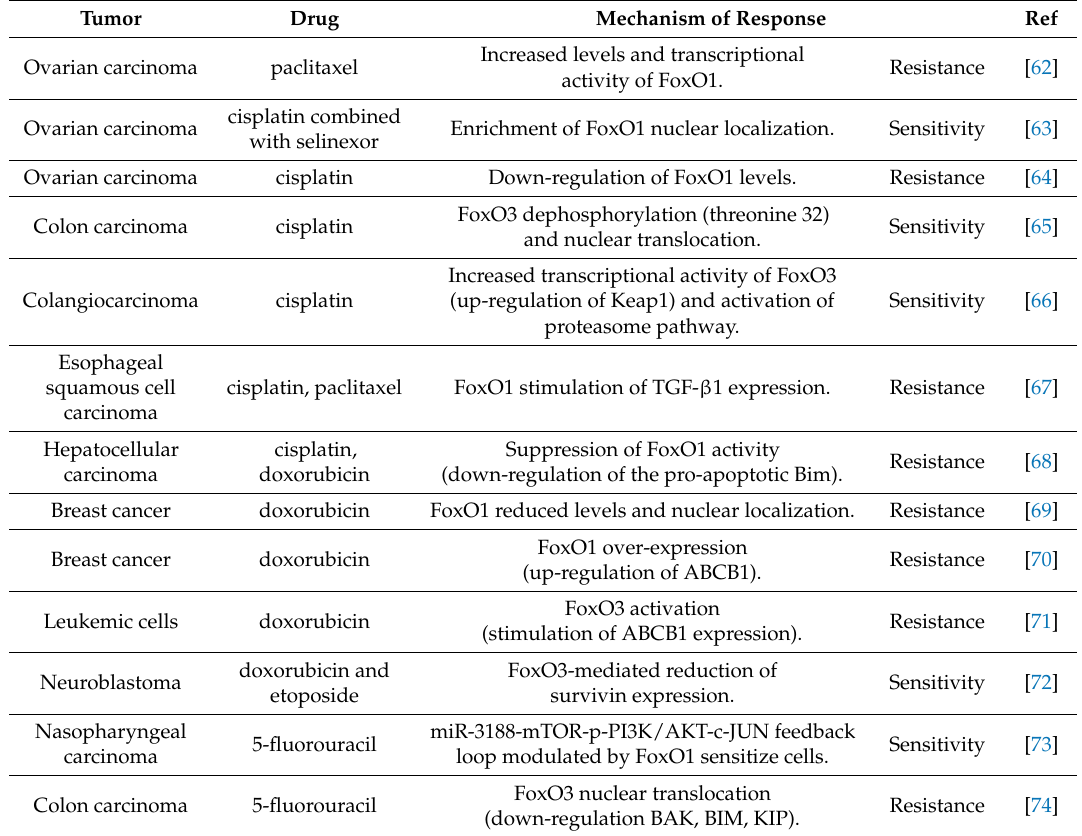
Figure 2. FoxO functions in cell response to antitumor drugs. The main cellular pathways regulated by FoxOs and involved in drug response and resistance of conventional and target-specific antitumor drugs are reported. The drug and the corresponding cellular response pathway are shown in different colors. Table 1. FoxO role in cell sensitivity and resistance to conventional